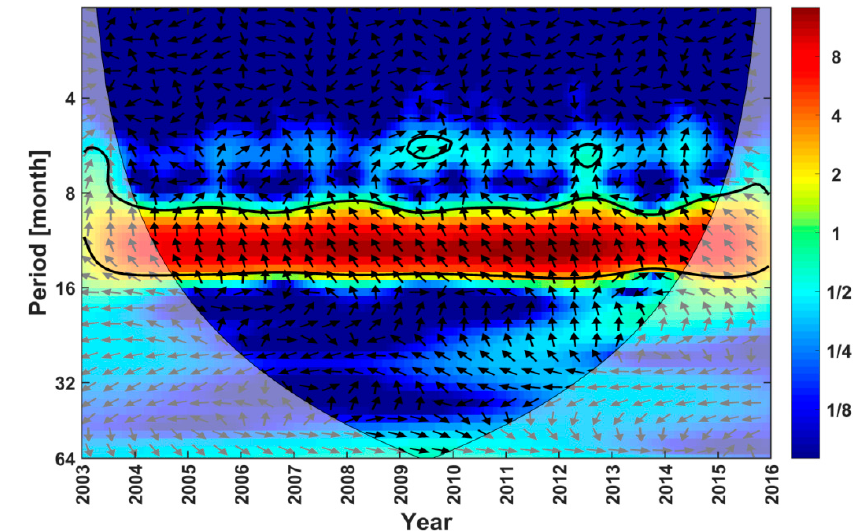
Figure 9. Cross wavelet transform of ice sheet mass and land surface temperature fluctuations. Arrows indicate relative phase relations, where straight-up arrows represent ice sheet changes, and land surface temperature shows an anti-phase relationship.